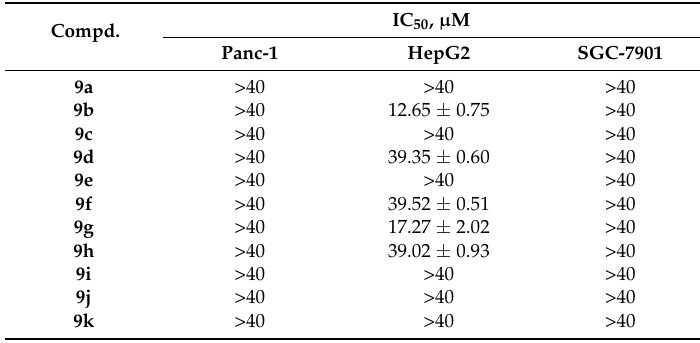
Table 3. Antiproliferative activity of compounds 9a – 9w